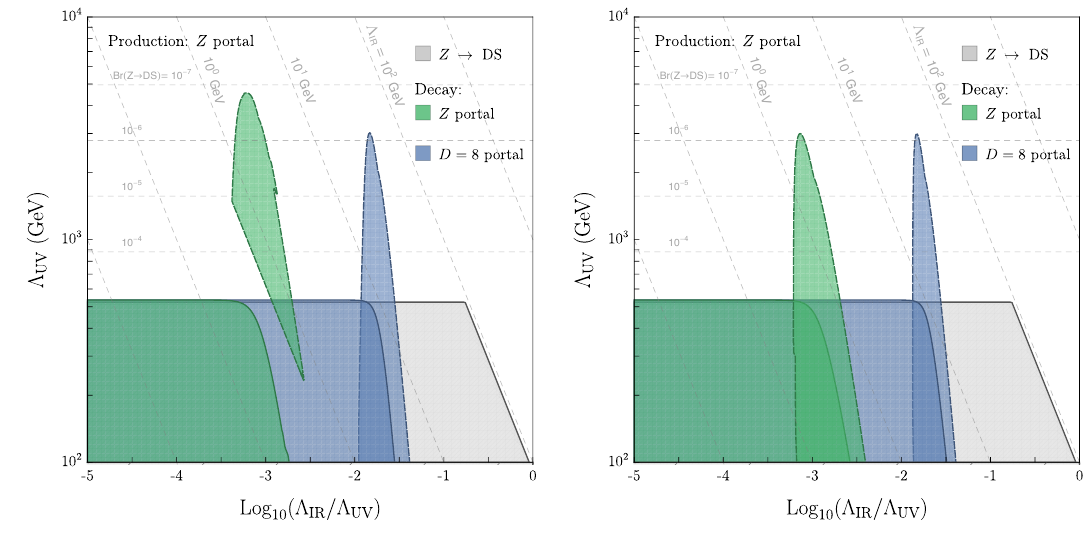
Figure 6 . Constraints on resonant DS production through the Z portal. The plot on the left (on the right) assumes a strongly (weakly) coupled dark sector. Exclusion regions from the mono-jet search of ref. [60] (solid contours) and the searches for displaced vertices of refs. [57, 58] (dashed contours) are shown for two different types of LDSP decay portal: the same Z portal responsible for the production (green), and a generic D = 8 portal (blue). The exclusion from the invisible width measurement at LEP of eq. (4.5) is shown in gray. Both plots assume κ 2